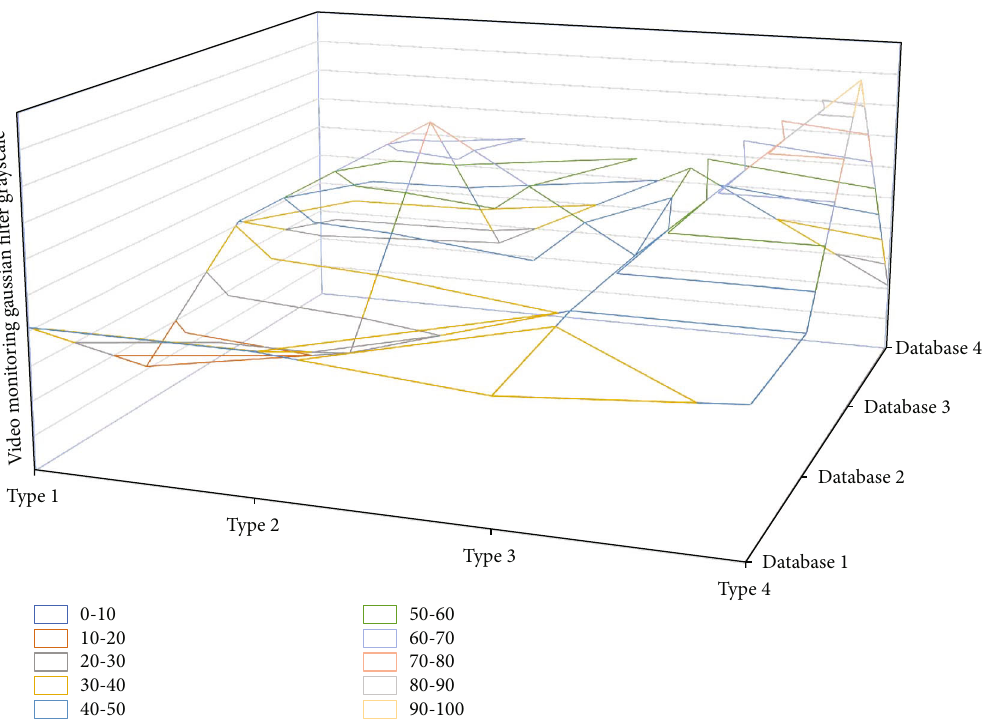
Figure 8: Video monitoring Gaussian fi lter gray processing